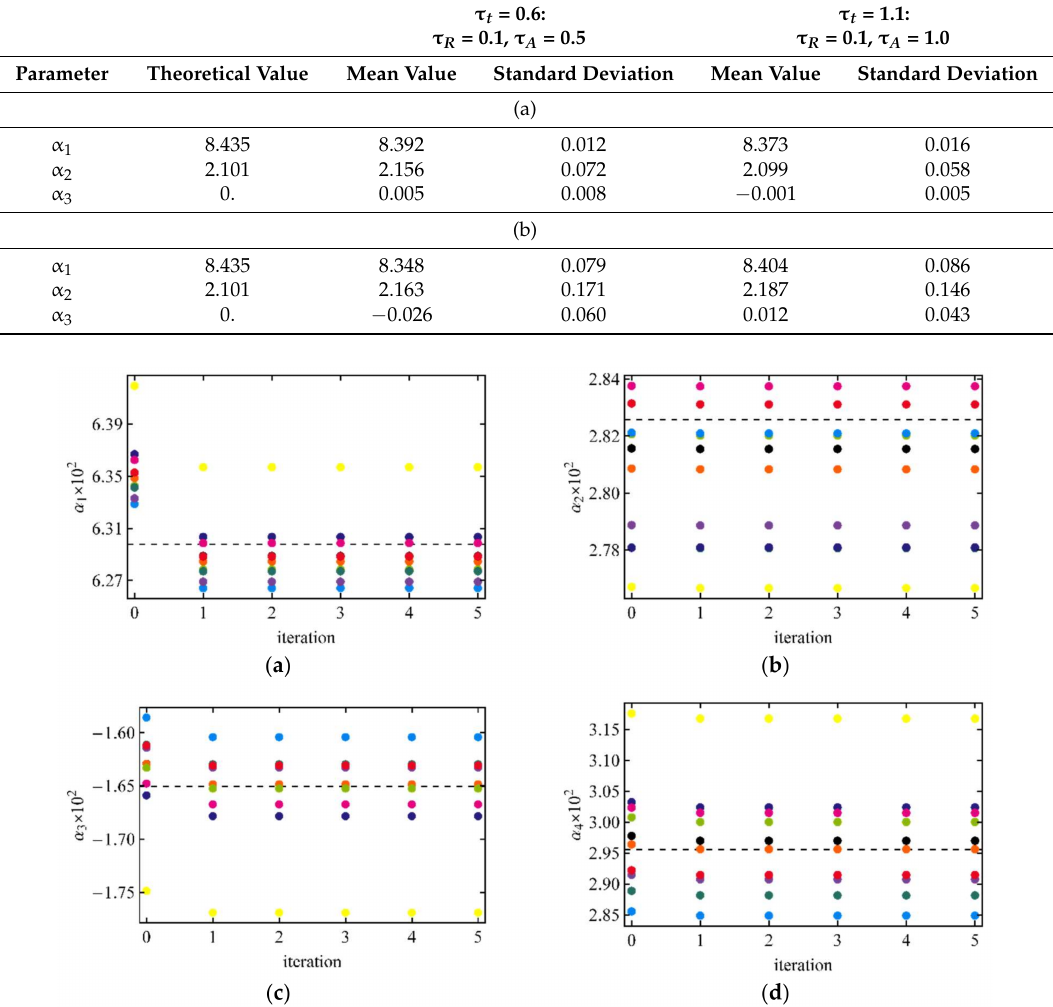
Figure 1. Convergence of coefficients α l ( × 100) in the case of BRDF (Equation (13)) with τ R = 0.1, τ R = 0.1. Different colors are 10 random realizations of 12 observations. Dashed lines—theoretical values. ( a ) α 1 ; ( b ) α 2 ; ( c ) α 3 ; ( d ) α 4 .